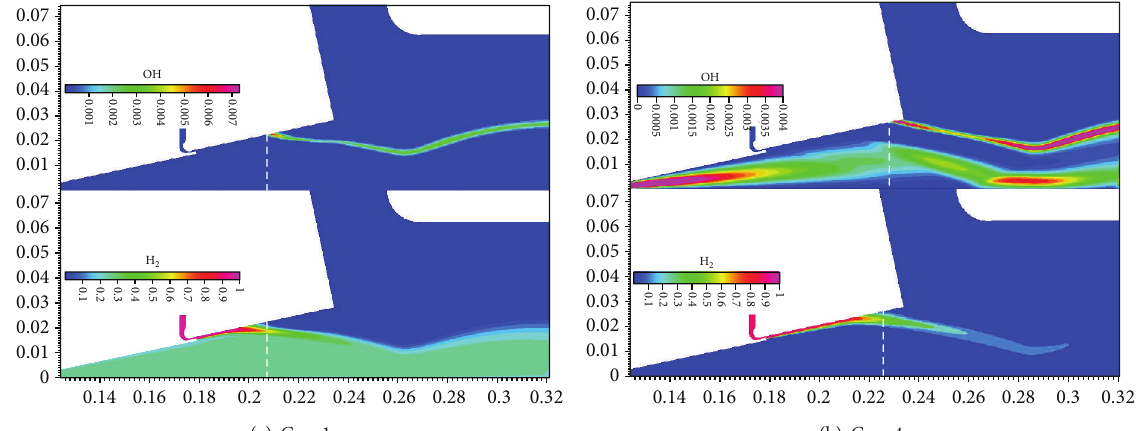
Figure 8: Calculated OH radicals and H 2 concentrations: Evans and 𝑘 - 𝜀 calculations.